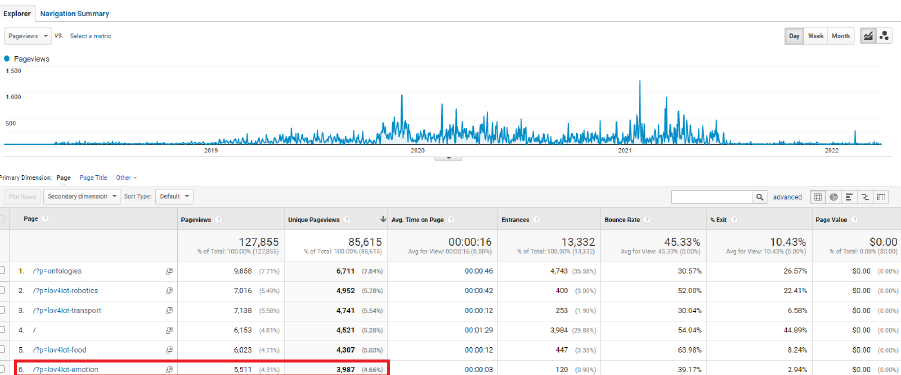
Figure 10. LOV4IoT Google Analytics per IoT domain (e.g.,